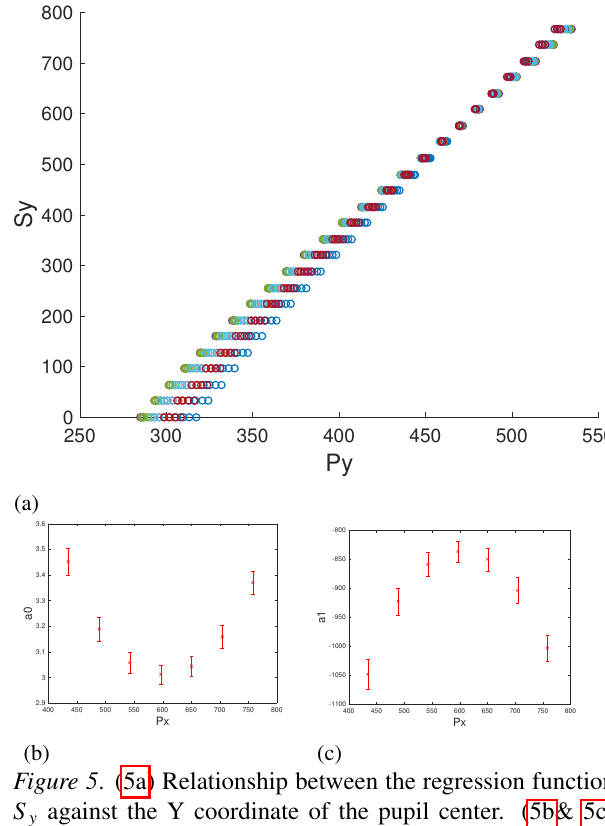
Figure 5 . (5a) Relationship between the regression function S y against the Y coordinate of the pupil center. (5b& 5c) Relationship between the coe ffi cients a i of S y against P x Interpolation and extrapolation regions